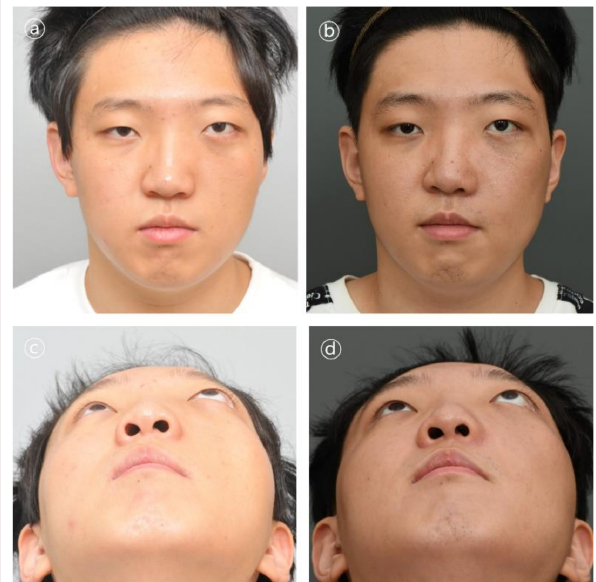
Figure 7. Clinical photographs in patient #5. Contour and symmetry of left cheek region was im- proved. ( a,b ) Pre- and postoperative 6-month frontal view photographs. ( c,d ) Pre- and postoperative 6-month basal view